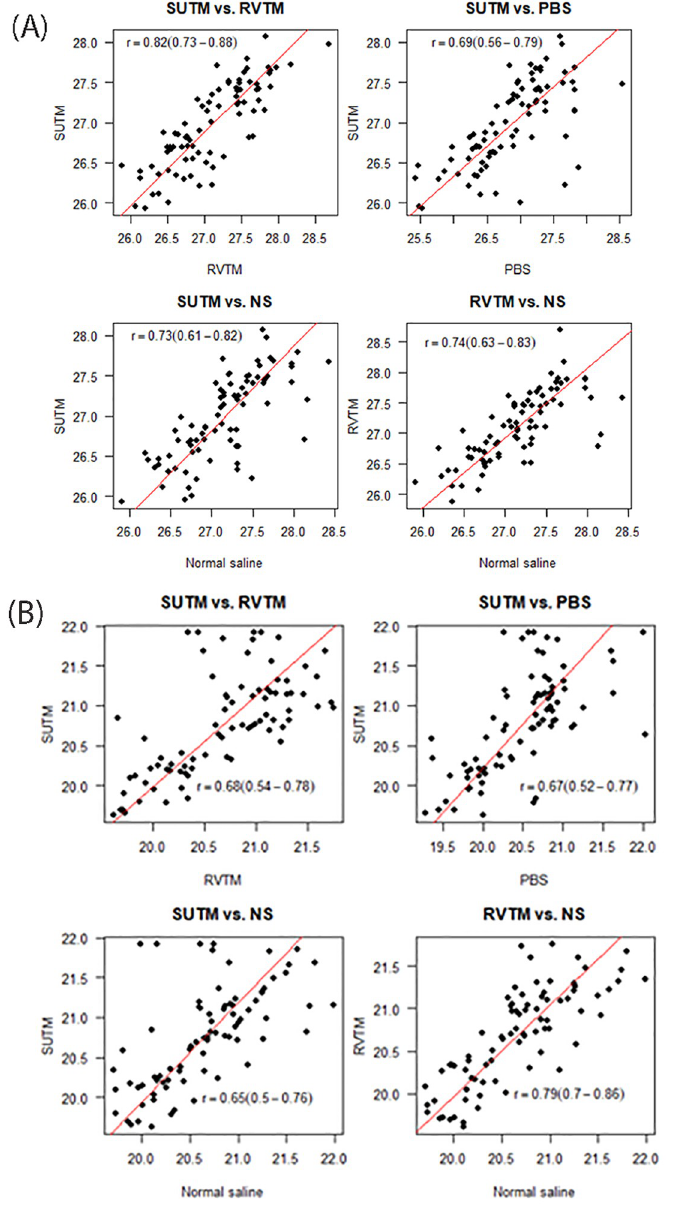
Fig 3. Correlations between Ct values from the 4 media types. (A) Scatter plots for Ct values at low concentration. (B) Scatter plots for Ct values at high concentration. The line of best fit was estimated using a Deming regression